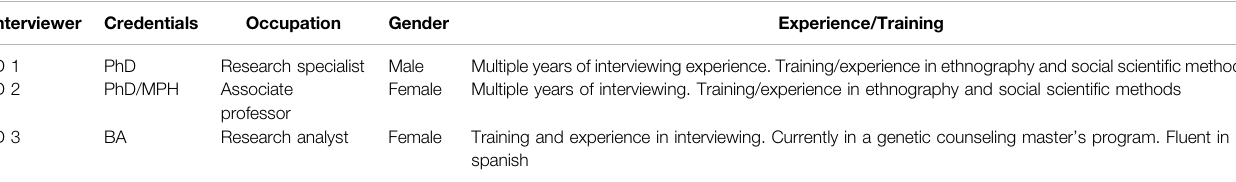
TABLE 2 | Key interviewee